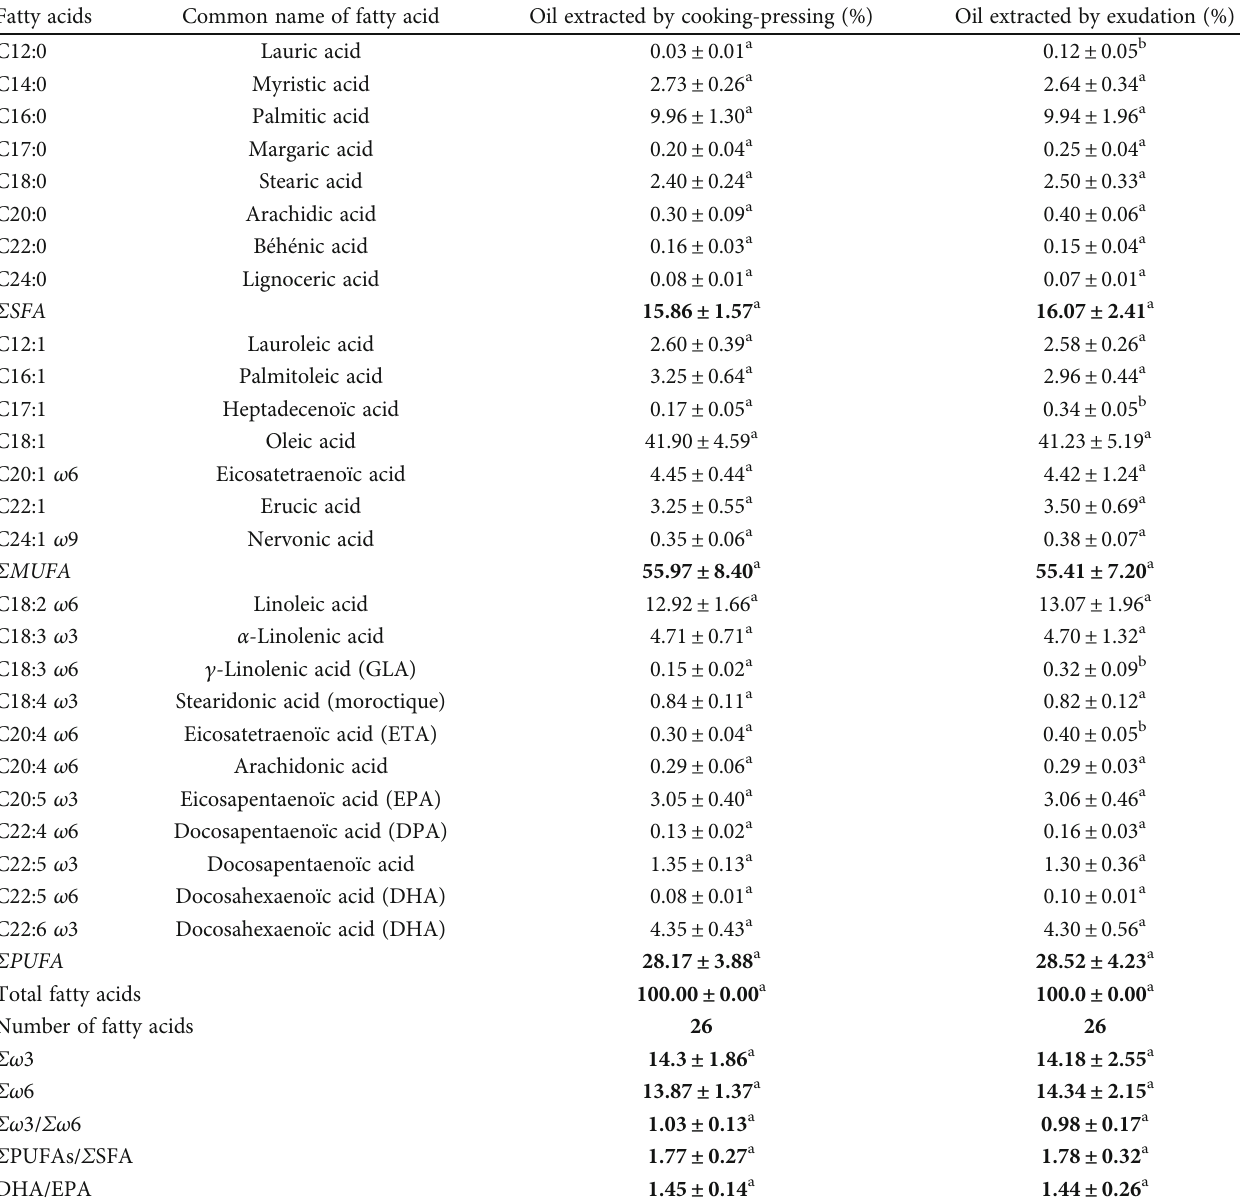
Table 2: Fatty acid pro fi le of Fontitrygon margarita liver oils according to the extraction method. Fatty